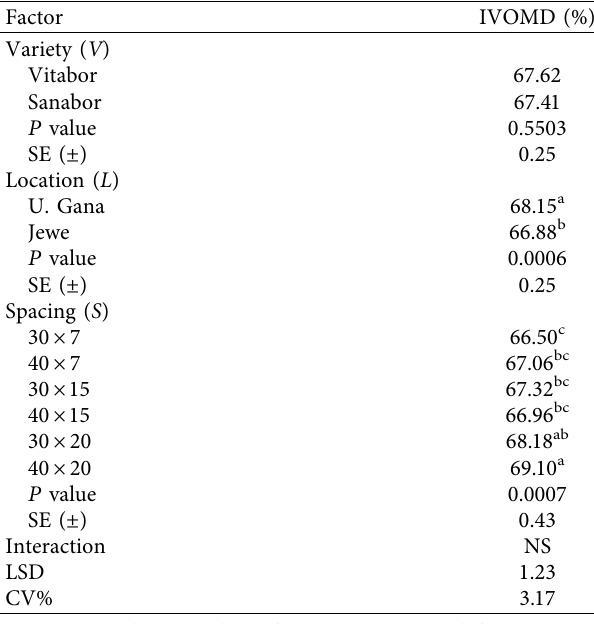
Table 4: Effects of location, spacing, and stage of flowering on CP, NDF, ADL, and ME content of sweet lupine forage.